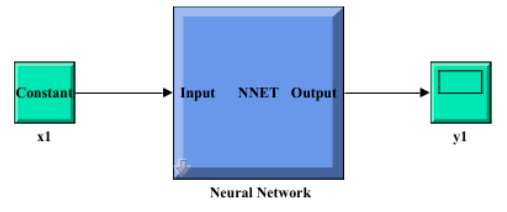
Figure 12. Simulink model of an ANN.